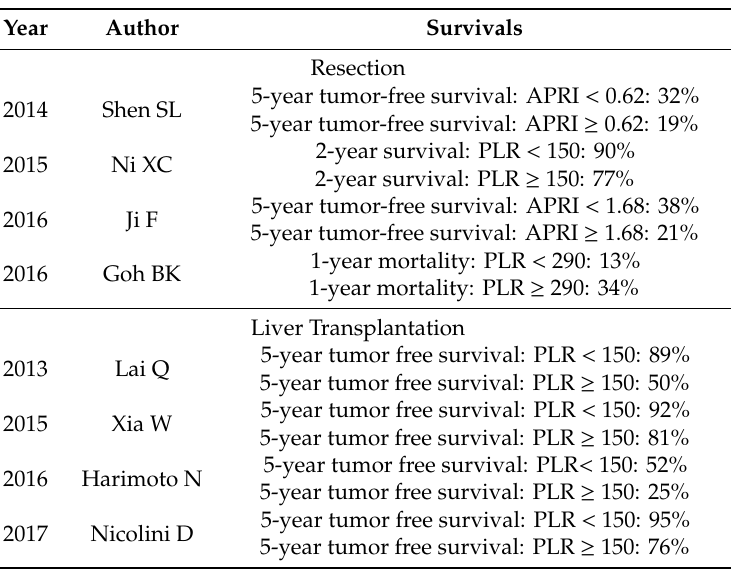
Table 3. Studies reporting the negative clinical impact in HCC patients showing high platelet count in terms of tumor-free or overall survival rates after curative